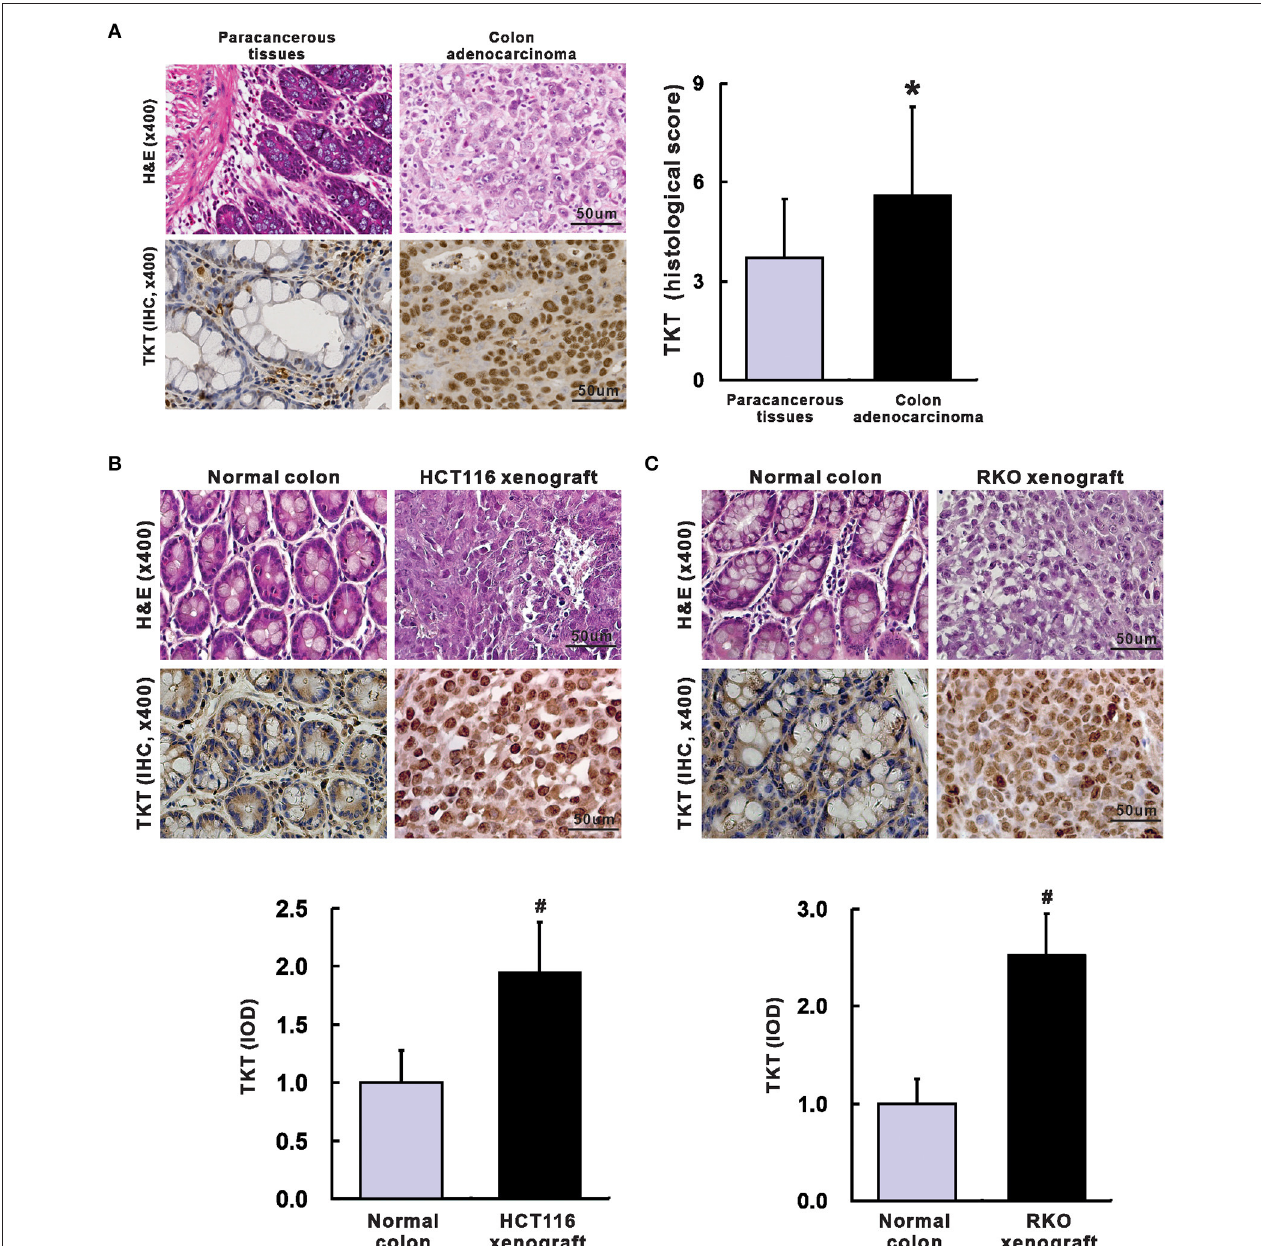
FIGURE 2 | Up-regulation of TKT in colon adenocarcinoma. (A) Representative images for H&E (left up) and IHC of TKT (left lower) were shown, and the histological score of TKT for colon adenocarcinoma tissues (right) was significantly higher than that for the corresponding paracancerous tissues, N = 60 in the paracancerous tissues group, N = 100 in the colon adenocarcinoma tissues group; (B) Representative images for H&E (upper panel of images) and IHC of TKT (lower panel of images) were shown, and the histological score of TKT for HCT 116 xenografts, whose expression was significantly higher than that for the corresponding normal colon tissues; (C) Representative images for H&E (upper panel of images) and IHC of TKT (lower panel of images) were shown, and the histological score of TKT for RKO xenografts, whose expression was significantly higher than that for the corresponding normal colon tissues, N = 6/group. * P < 0.05 vs . paracancerous tissues; # P < 0.05 vs . normal colon tissues in